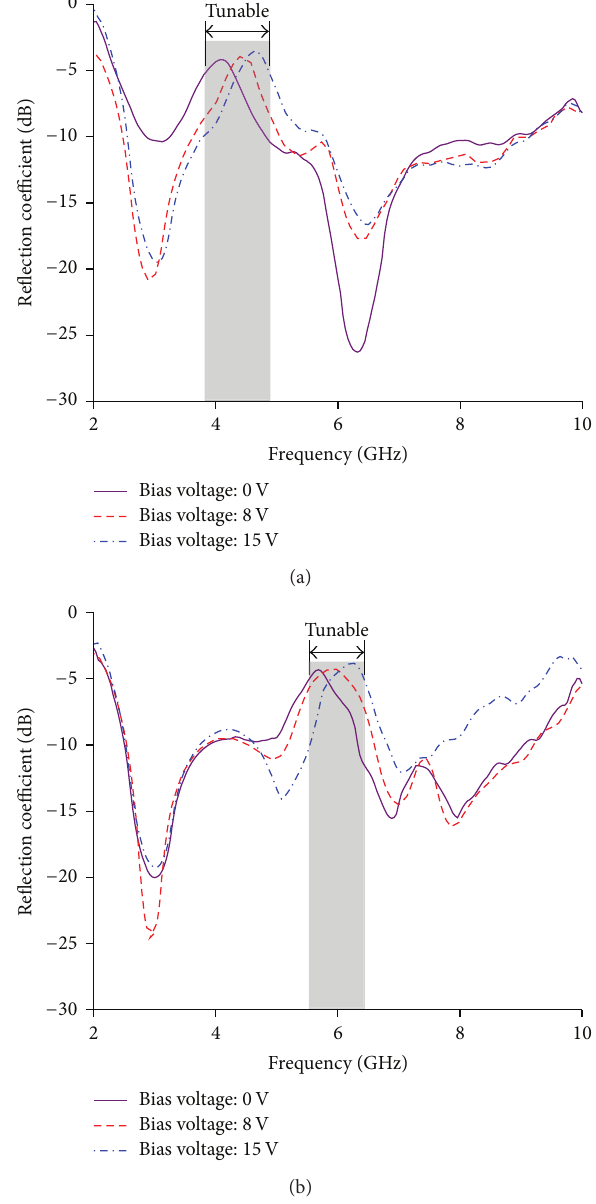
Figure 6: Measured reflection coefficient of the proposed recon- figurable band-notched UWB antenna with the reverse voltage on varactors varying from 0 V to 15 V: (a) the state of PIN diodes is ON; (b) the state of PIN diodes is